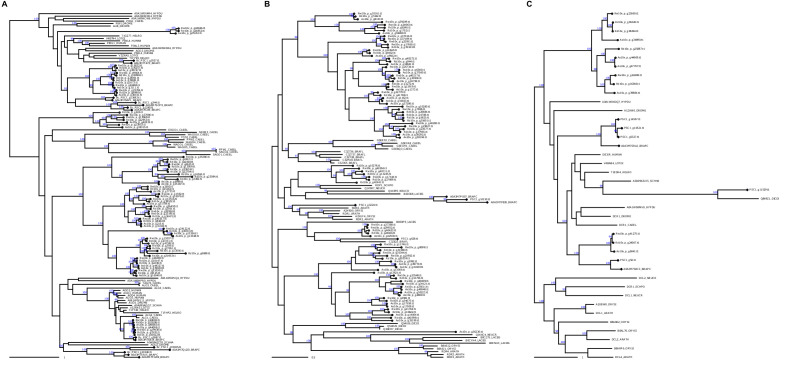
Argonaute, RdRP, and Dicer phylogeny details.Bdelloid copies are indicated with tip labels. Numbers on branches represent branching support (%) based on 5000 UFBoot samples, respectively. Scale bar indicates one amino acid substitution per site.